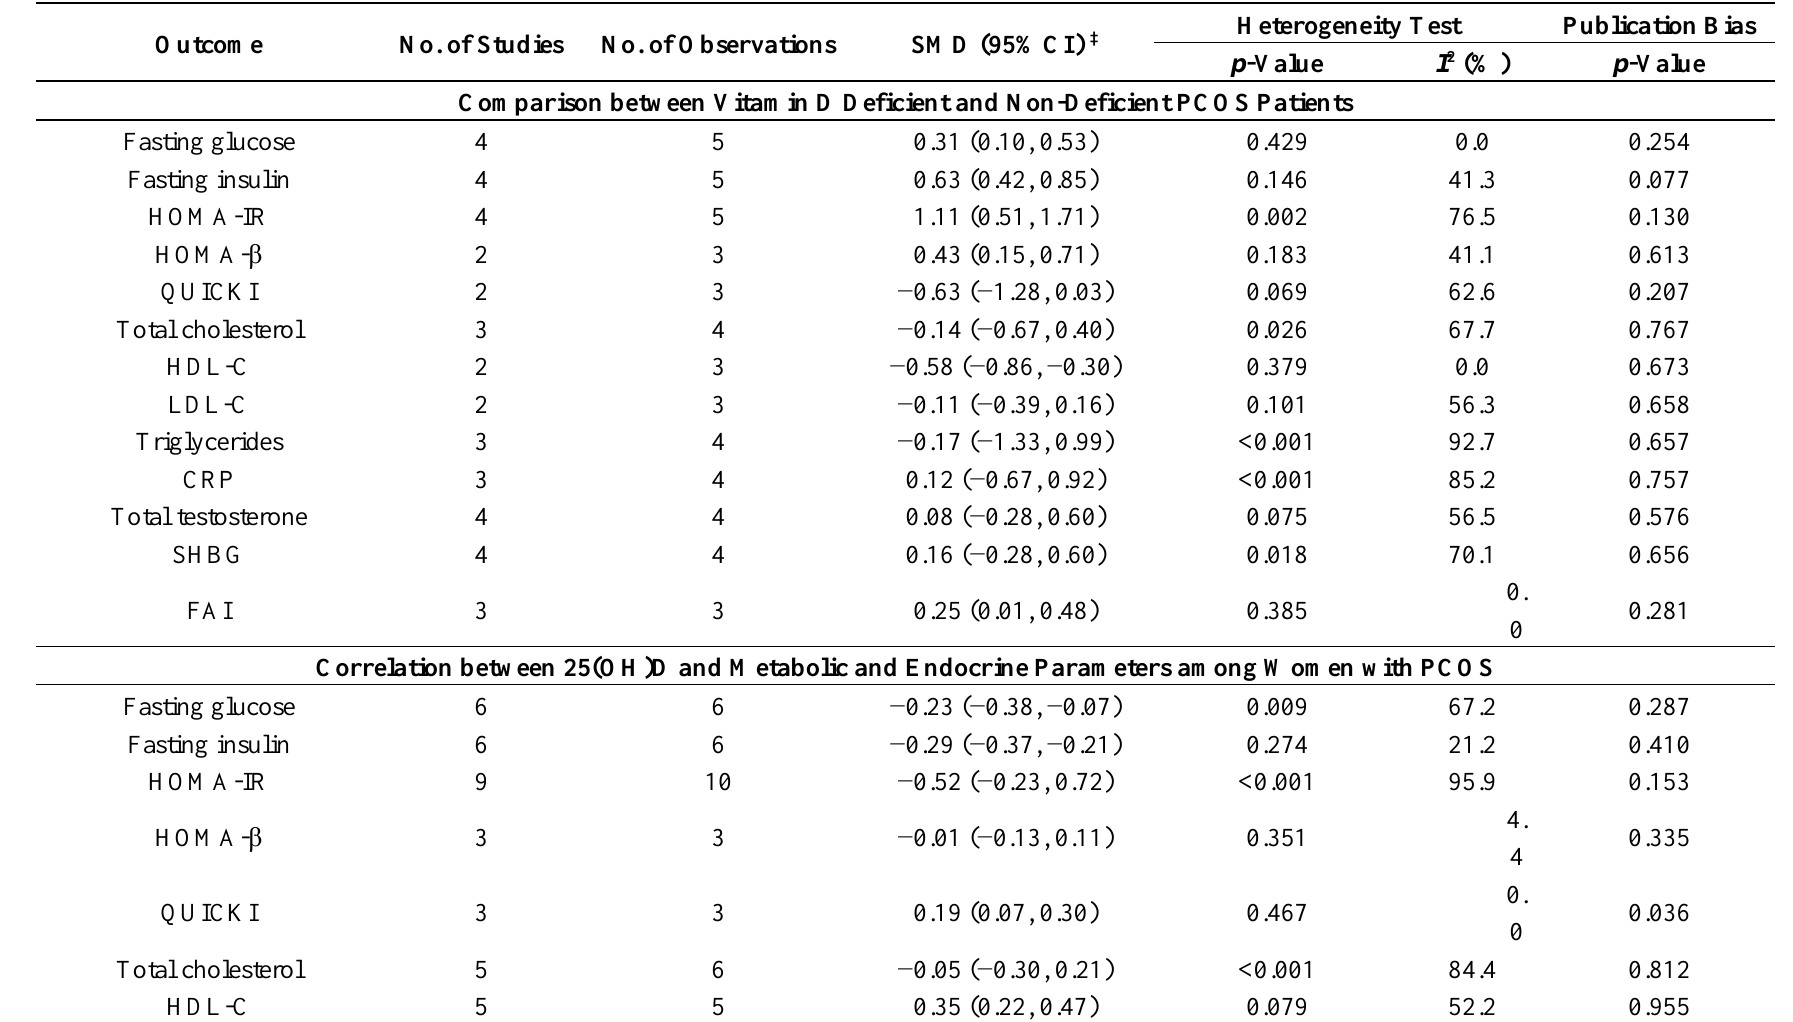
Table 2. Meta-analysis